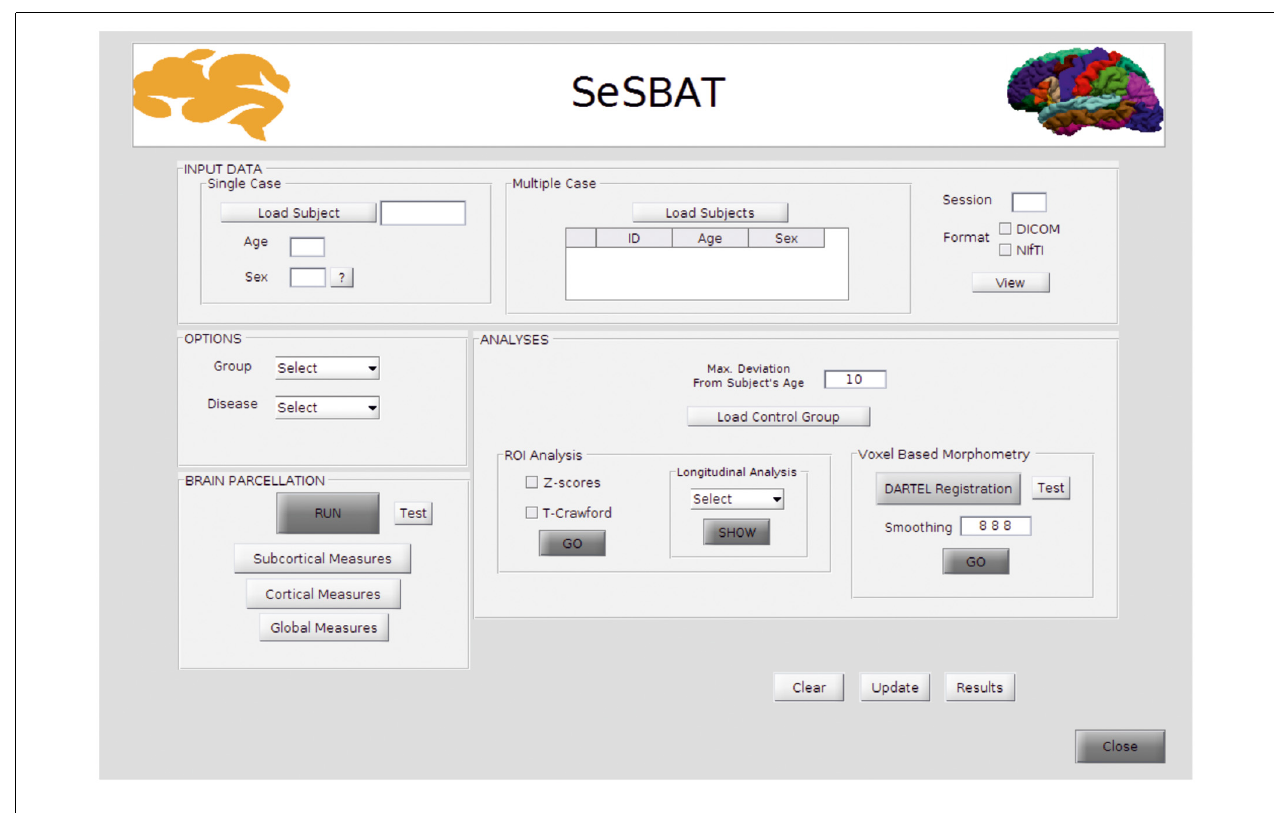
FIGURE 1 | Main graphical user interface (GUI) of SeSBAT.